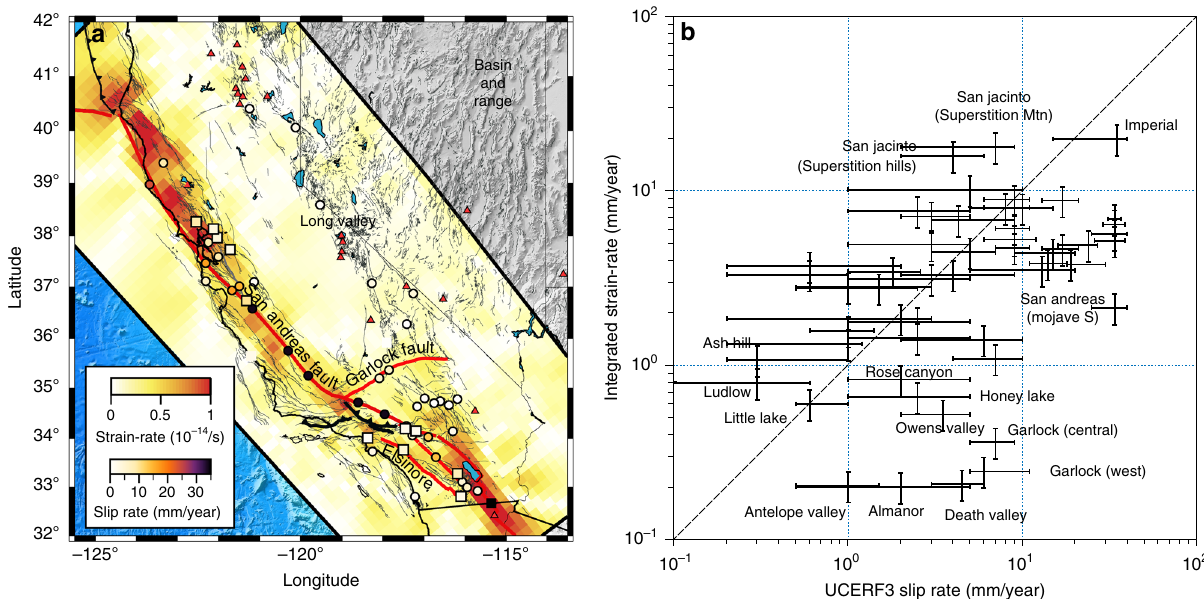
Fig. 8 Anelastic strain accumulation and long-term slip-rate on California faults. a Spatial distribution of distributed strain and the location of paleo slip- rate on strike-slip fault segments cataloged in Appendix B of the Uniform California Earthquake Rupture Forecast (UCERF3; https://pubs.usgs.gov/of/ 2013/1165/). The squares indicate locations where the deep strain-rate immediately below the fault segment matches the long-term fault slip rate. Red triangles indicate quaternary volcanos. b Comparison of the UCERF3 slip rates with the integrated strain-rate below the corresponding fault segment.